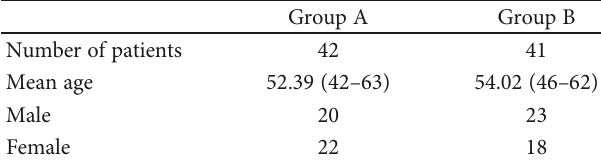
Table 1: Patient characteristics for groups A and B.